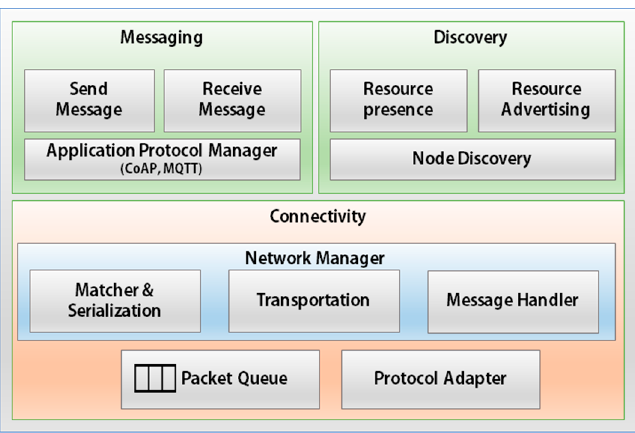
Figure 4. Interaction layer architecture.